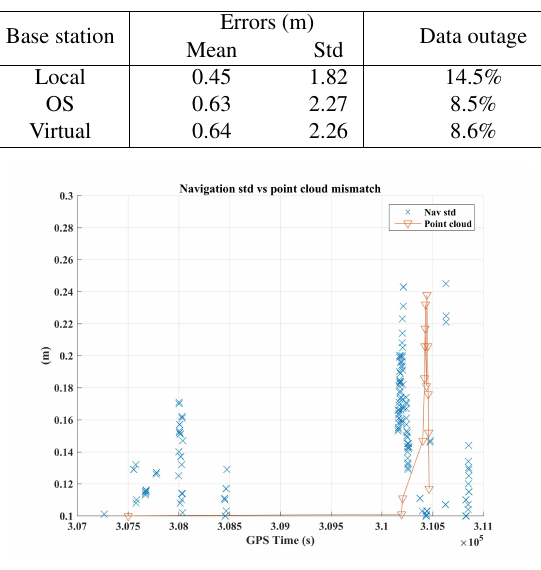
Figure 5: Navigation standard deviation compared with point cloud mismatch